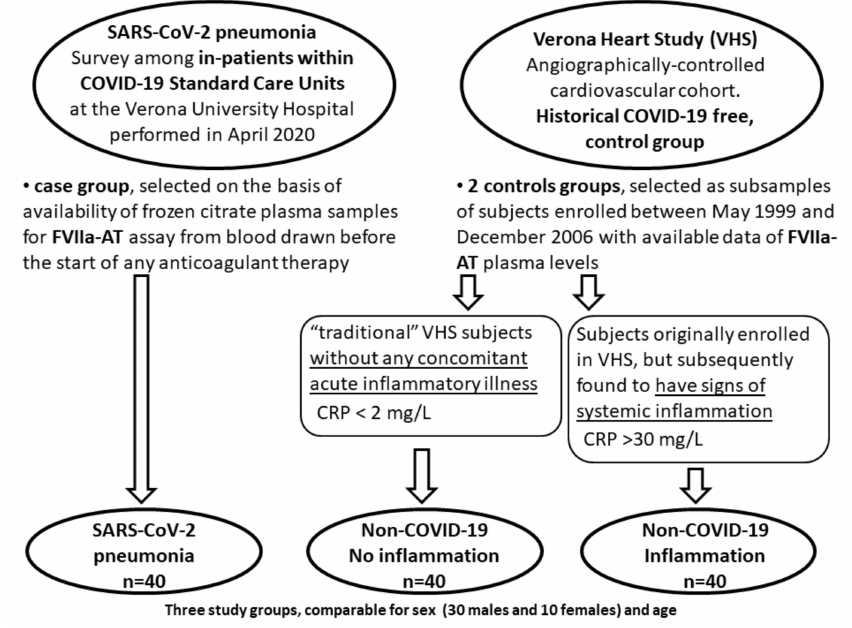
Figure 1. Schematic diagram of study design. Study design for the analysis of activated factor VII–antithrombin complex (FVIIa-AT) levels in patients with SARS-CoV-2 pneumonia. FVIIa-AT plasma levels, as well as other laboratory data of these COVID-19